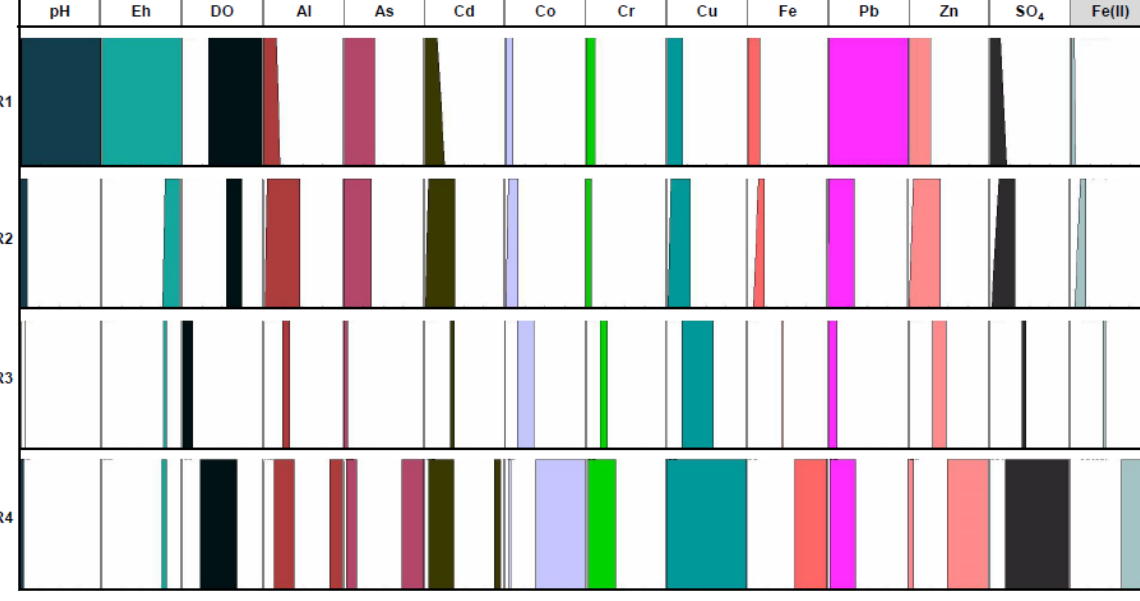
Figure 4. Fuzzy rules related to wet season taking Fe(II) as the consequent.